Question: Sum up the contents of this chart in one sentence.
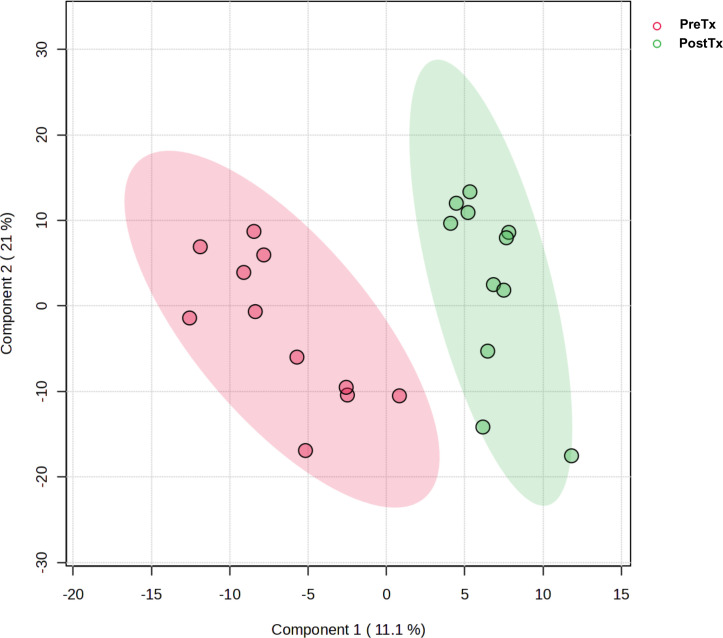
Answer: Partial least squares-discriminant analysis (PLS-DA) plot of differential metabolites in patients with congenital hypothyroidism pre- and post- the onset of treatment. The ellipse represents the 95% confidence interval based on Hotelling’s T2 statistics. Score plot derived from the PLS-DA model demonstrating group separation. Model robustness is indicated by R2Y = 0.9 (goodness-of-fit) and Q2 = 0.6 (predictive capacity). Q2 was cross-validated to ensure model stability. The optimal number of classification components was determined via 5-fold cross-validation (5-fold CV), with model performance evaluated based on the Q2 score.